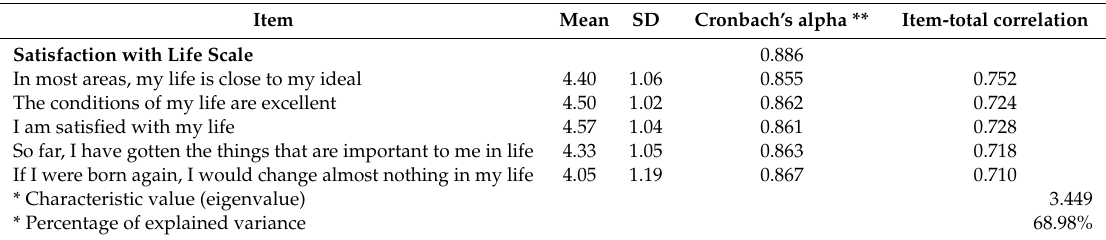
Table 2. Mean, Standard Deviation (SD), Cronbach’s alpha, and Item-Total Correlation of Each Item in the Satisfaction with Life Scale and Subjective Well Being